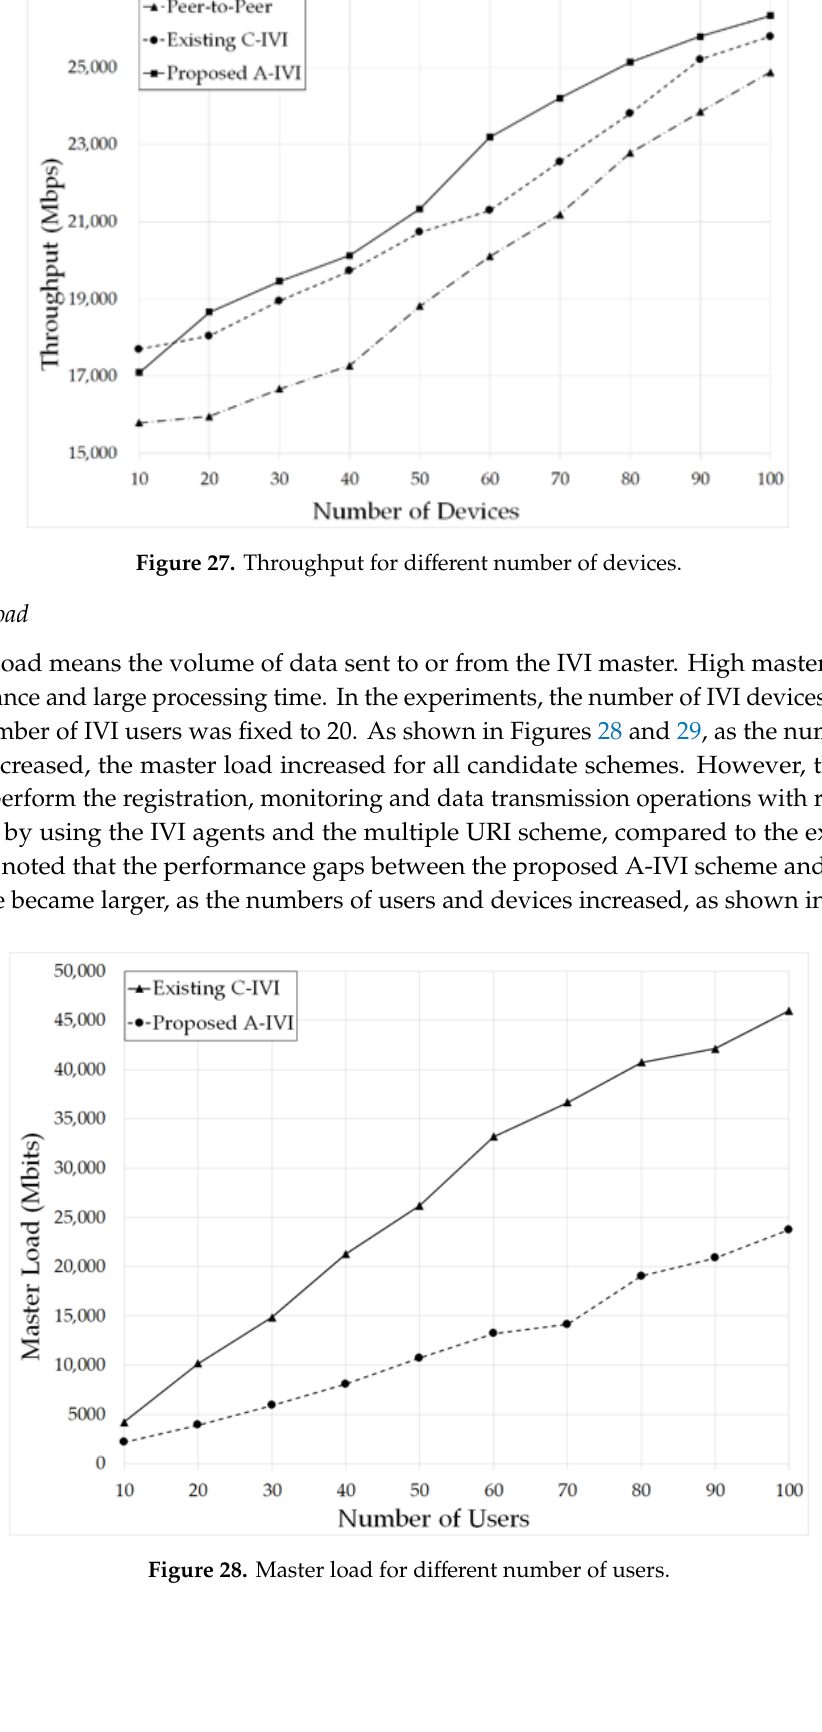
Figure 29. Master load for different number of devices. 6. Conclusions and Future Works In this paper, we proposed agent-based IVI systems to provide more effective communication between IVI users, the IVI master, and IVI devices. In the proposed A-IVI system, we introduced a new entity, an IVI agent, which is responsible for a group (cluster) of IVI devices in the IVI system. The IVI master will communicate with the IVI devices via the IVI agent. With the help of IVI agents, performance can be enhanced, and the loads of IVI master can also be reduced. By implementation of the proposed A-IVI scheme and the testbed experimentations, the proposed A-IVI scheme was compared with the existing peer-to-peer and C-IVI schemes. From the experimental results, we can see that the proposed A-IVI scheme provides better transmission delays and throughput performance than the existing peer-to-peer and C-IVI schemes, in particular, in case there are ten or more IVI devices in the vehicle.